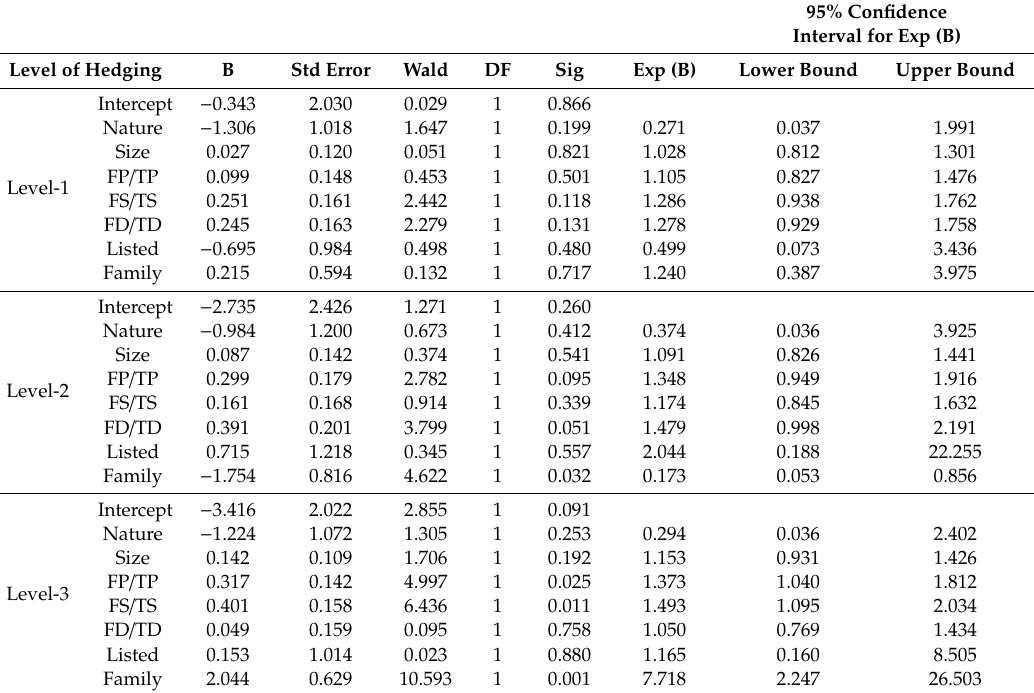
Table 7. The covariance matrix for the three levels of hedging in comparison with no hedge